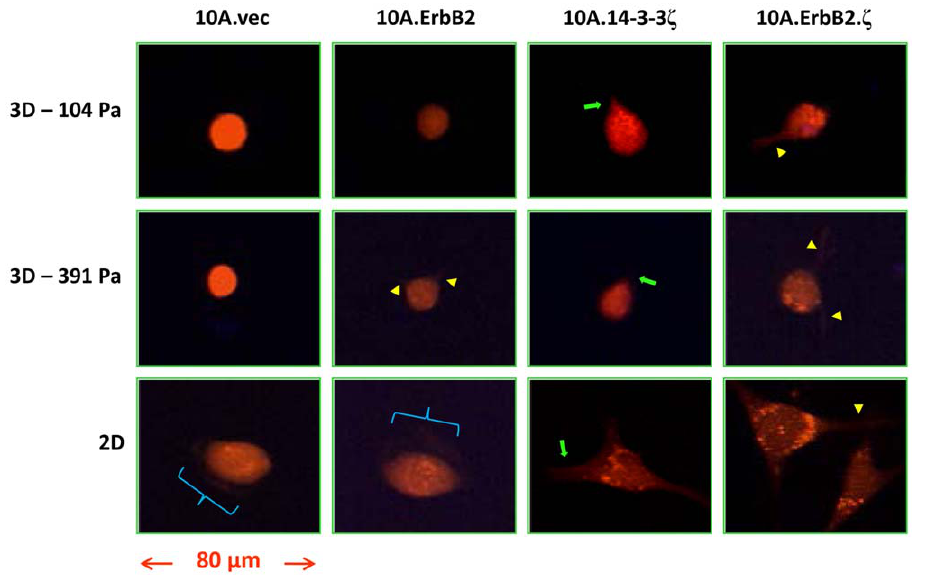
Figure 4. Single-plane confocal images of MCF10A cells embedded within 3D Type I collagen matrices and cultured atop 2D Type I collagen matrices. Top row lists cell line; left column lists matrix condition. Yellow carats indicate thin, rod-like cellular processes. Green arrows indicate tubular-shaped cellular protrusions. Blue brackets indicate sheet-like cellular protrusions.